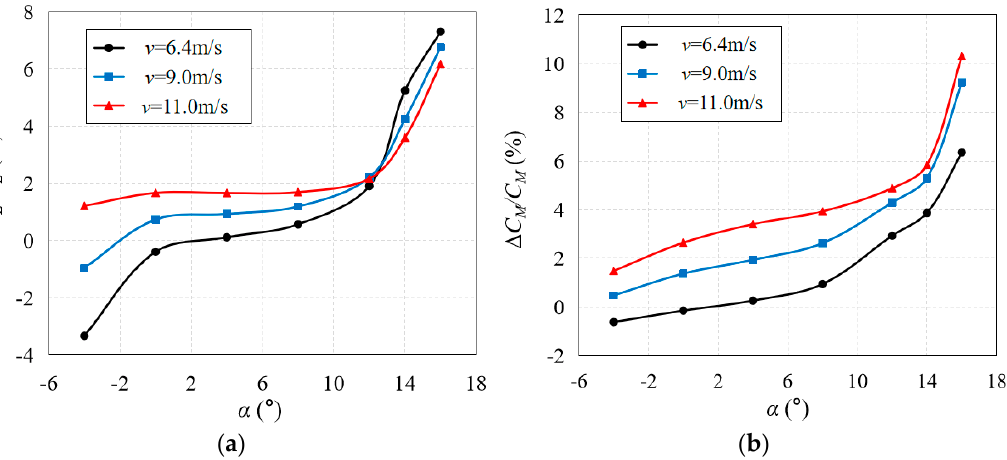
Figure 22. Numerical simulation of lift characteristics of rigid-/polyimide-skin wing: ( a ) v = 6.4 m/s; ( b ) v = 9.0 m/s; ( c ) v = 11.0 m/s. ( b ) v = 9.0 m/s; ( c ) v = 11.0 m/s.